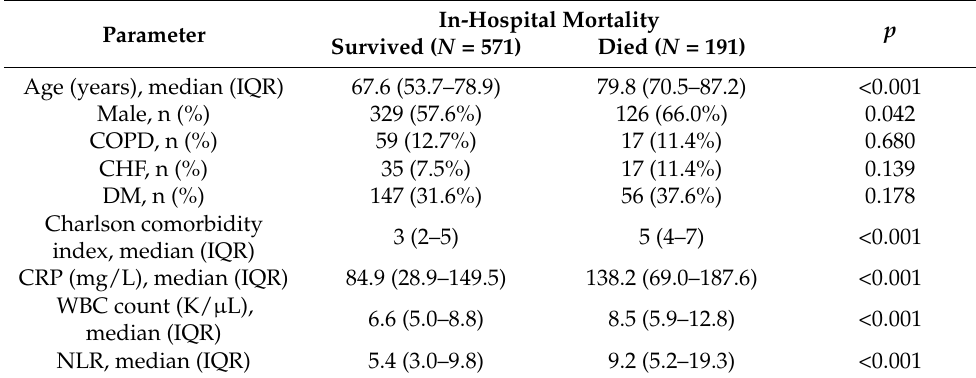
Table 2. Univariate analysis of the predictors for in-hospital mortality.